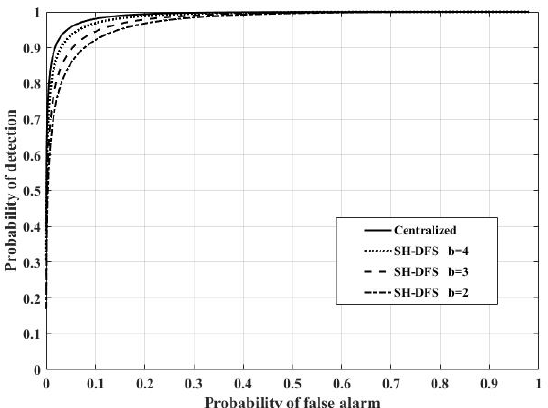
Figure 16. The probability of detection of the clustered distributed system with SH-DFS ( b = 2, 3, 4) and the centralized system versus the global desired probability of false alarm at the FC.